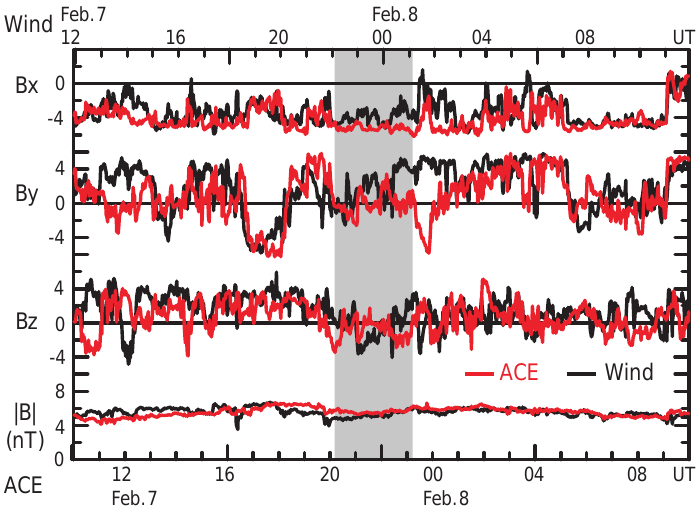
Fig. 2. High resolution IMF data from ACE (red) and Wind (black). The time has been shifted by 115 min to match the large-scale structures.